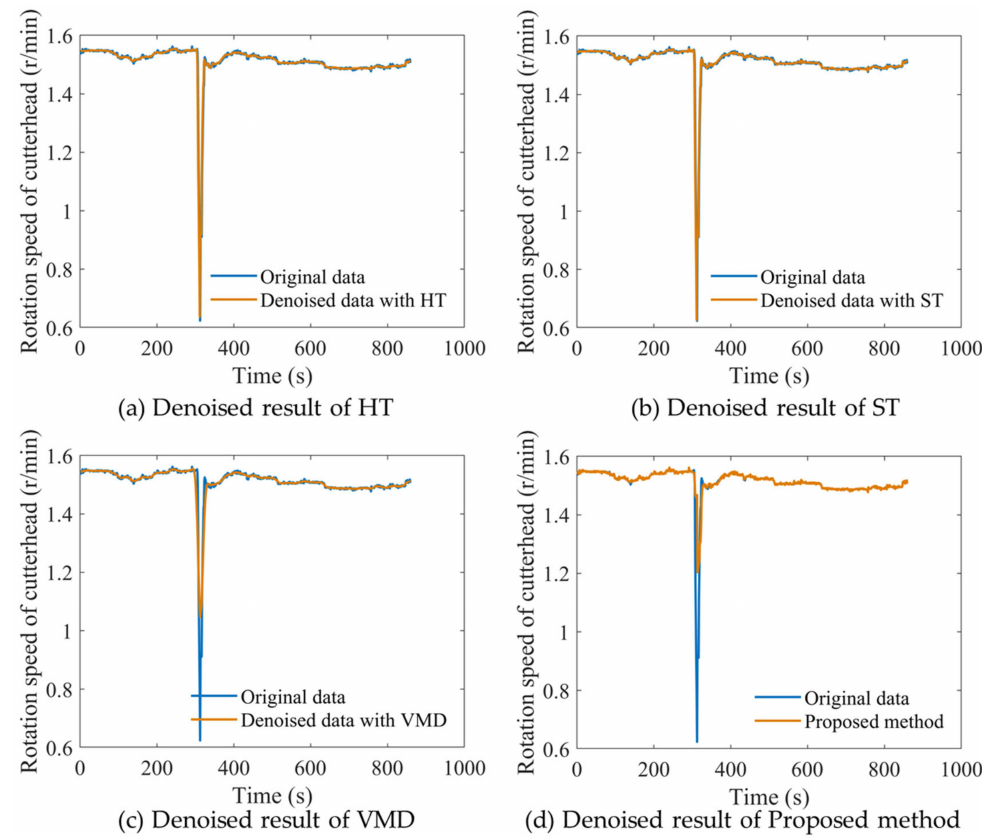
Figure 7. Comparisons between real and denoised data for dataset